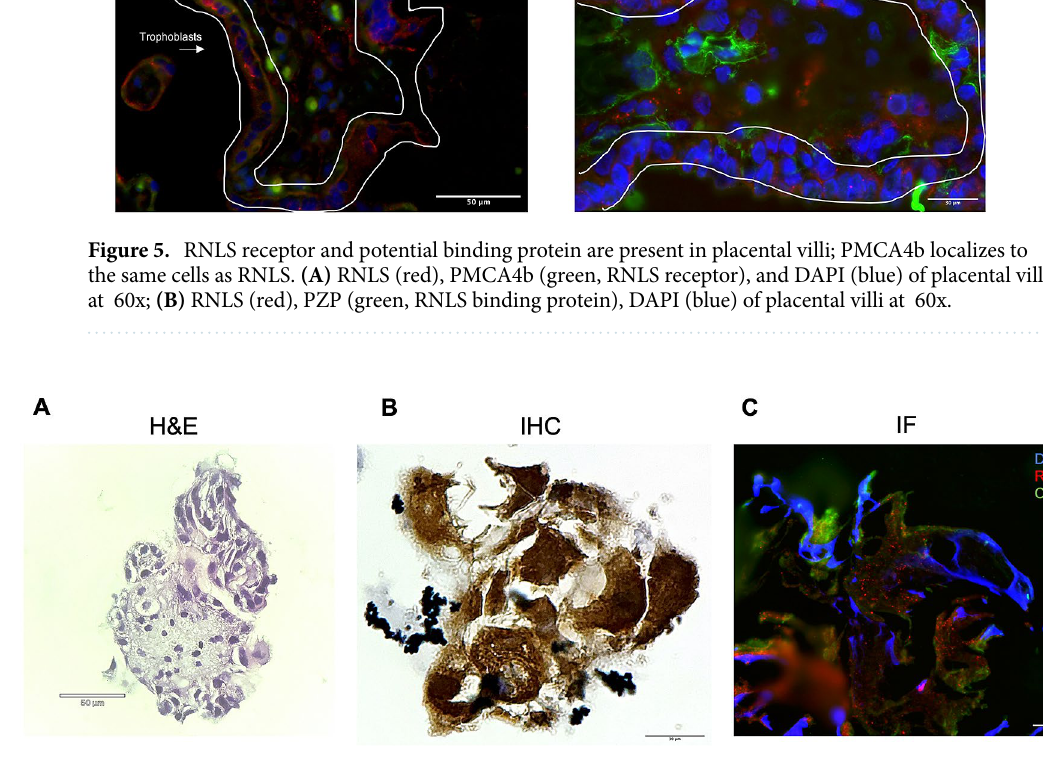
Figure 6. RNLS is produced endogenously in placental trophoblasts. (A) Hematoxylin and eosin stain of placental organoid at 40x; (B) immunohistochemistry staining of RNLS in placental organoid at 60x; (C) immunofluorescence of RNLS (red), Cyt19 (trophoblast, green), and DAPI (blue) of placental organoid at